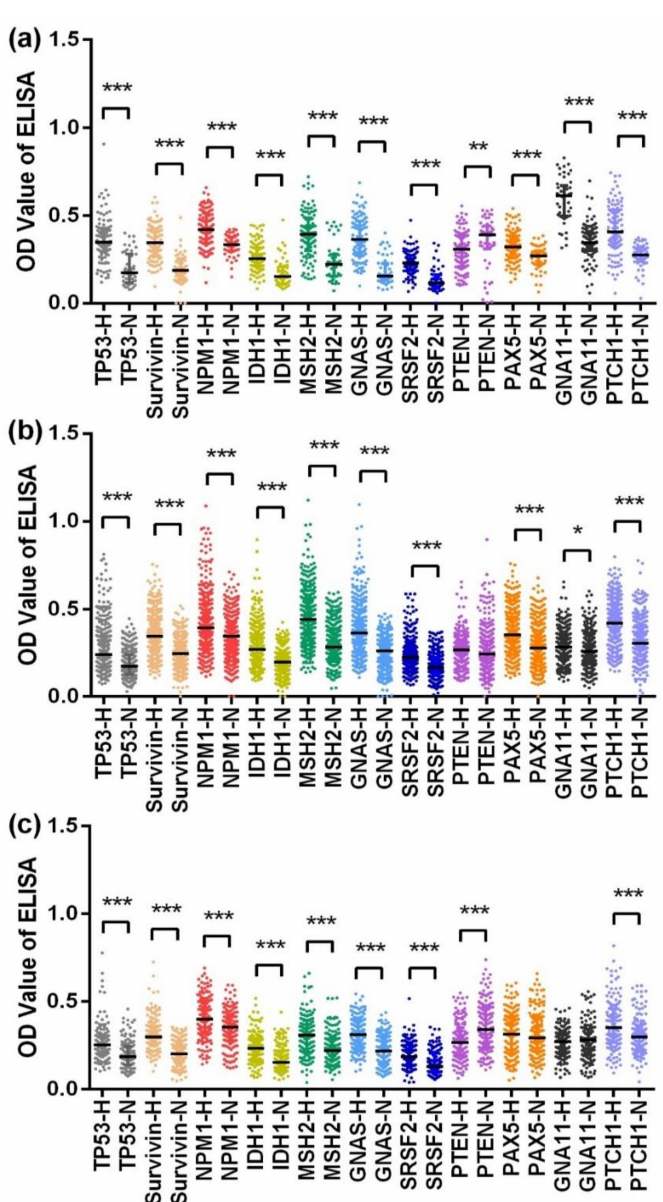
Figure 2. Scatter plots of the optical density (OD) value of ELISA for 11 anti-TAA autoantibodies in the verification dataset ( a ), training dataset ( b ), and validation dataset ( c ). *** p < 0.001, ** p < 0.01, * p < 0.05. H, hepatocellular carcinoma; N, normal control. The lines on scatter plots are median with interquartile